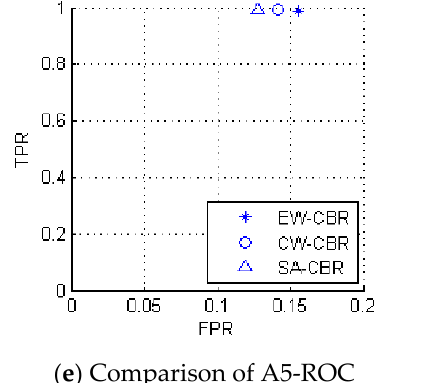
Figure 7. Comparison of the ROC diagram.